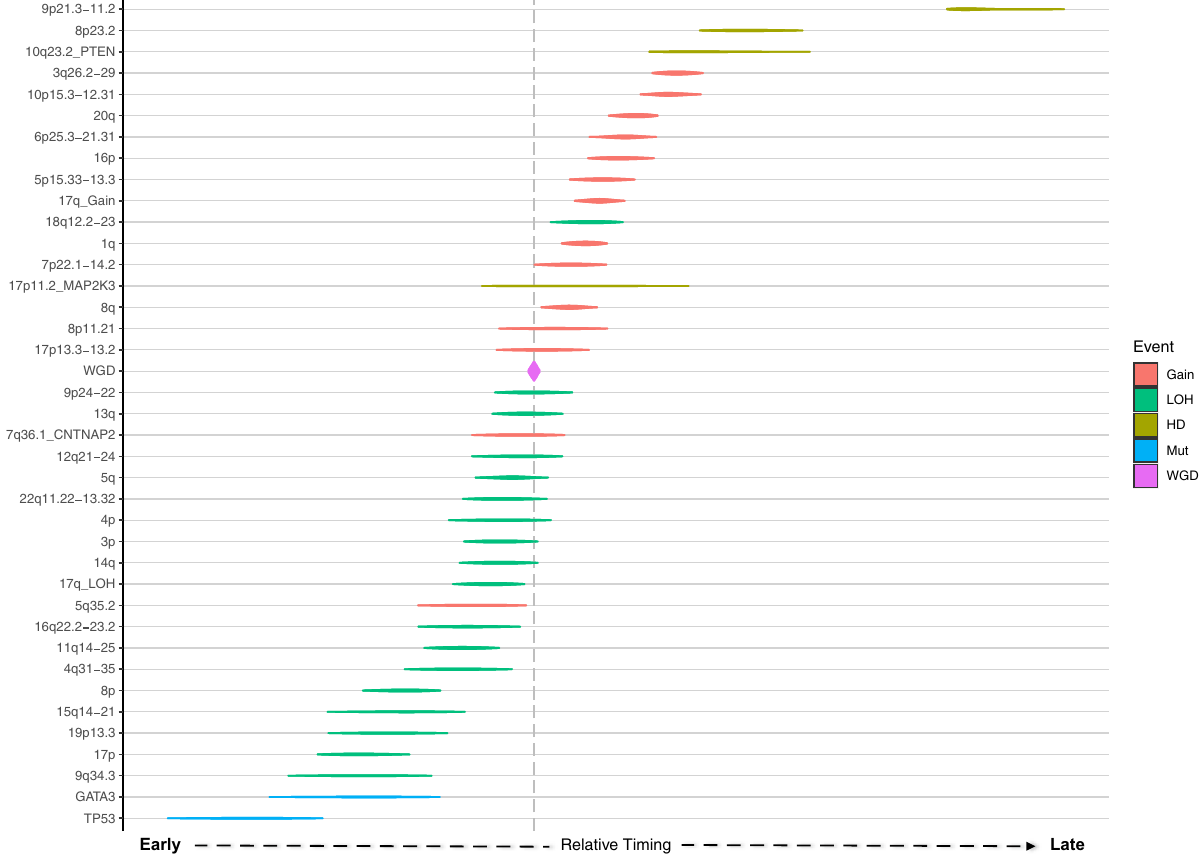
Fig. 6 Chronological ordering of genomic events in Nigerian breast tumors. Clonality-based ordering of signi fi cantly enriched copy number events (FDR < 0.05), whole-genome duplication (WGD), and key frequent mutational drivers ( TP53 and GATA3 ). A Plackett-Luce model was used to order the events by sampling from all possible tumor phylogenies across the entire dataset (1,000 iterations). Violins represent the 95% con fi dence interval of the relative timing estimate for each event. The events are ordered early to late by the mean value of the relative timing estimates. The vertical dotted line represents the mean timing estimate of WGD across all samples. LOH loss of heterozygosity, HD homozygous deletion, Mut mutational